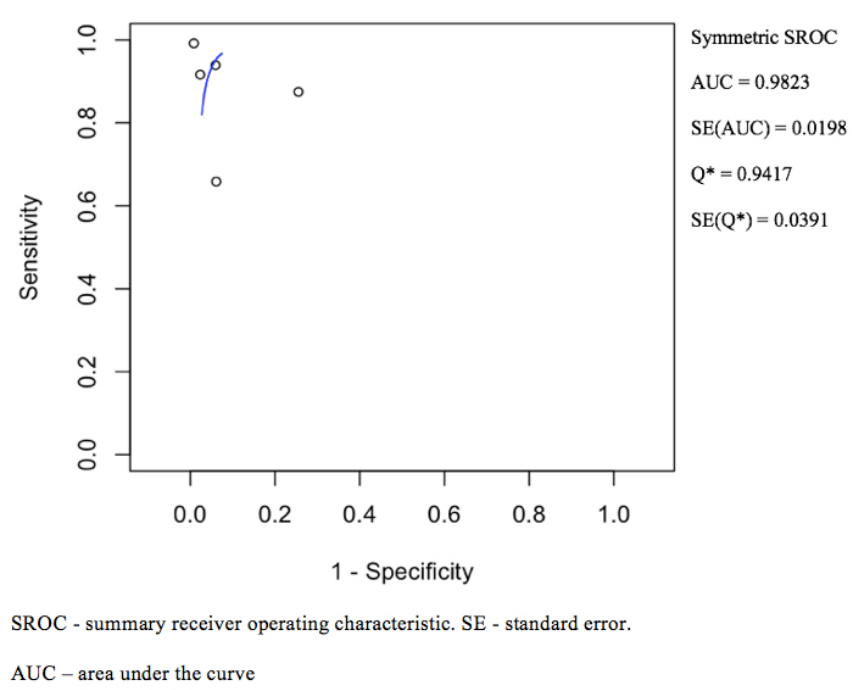
Figure 4. Narrow-band imaging summary receiver operating characteristic curve illustrated the accuracy of nasoendoscopy with narrow-band imaging settings. Area under the curve and standard error was calculated.